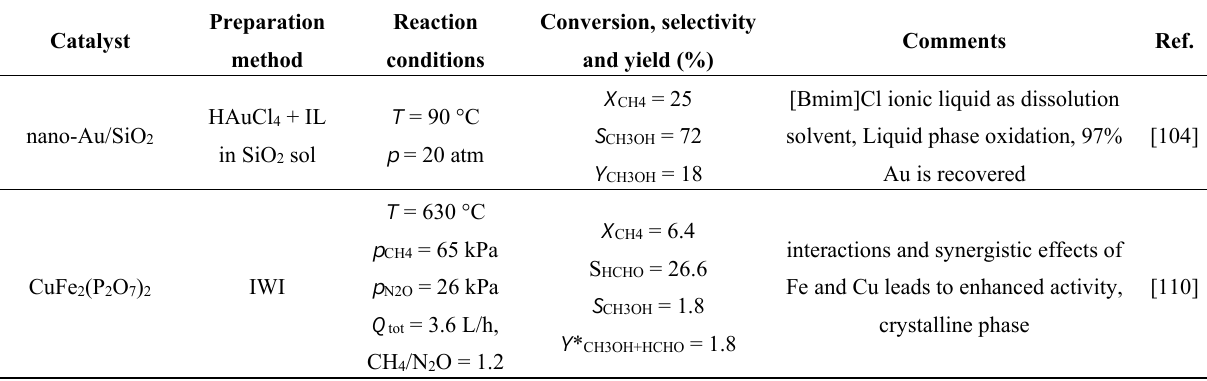
Table 5. A few selected catalysts studied in methane to C 1 oxygenates (mostly CH 3 OH and HCHO) under different reaction